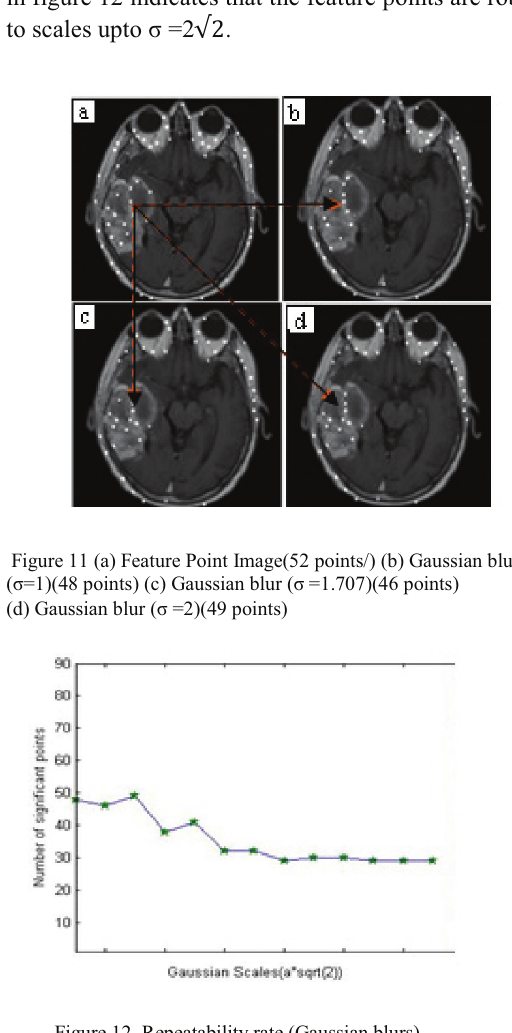
Figure 12. Repeatability rate (Gaussian